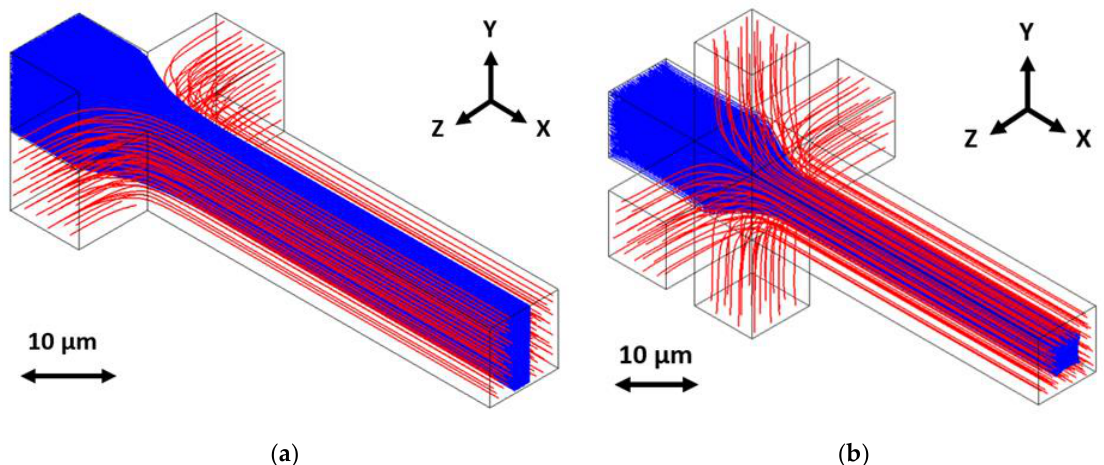
Figure 1. Conceptual illustration of hydrodynamic focusing methods, with the sample streams given in blue and the buffer streams given in red: ( a ) A two-dimensional hydrodynamic focusing (2DHF) method has two inlets coming from the side to focus the sample horizontally; ( b ) A three-dimensional hydrodynamic focusing (3DHF) method has two inlets coming from top, bottom, and sides to focus the sample horizontally and vertically. This figure is cited from Hamilton et al. in Micromachines [15] under Creative Commons Attribution License.